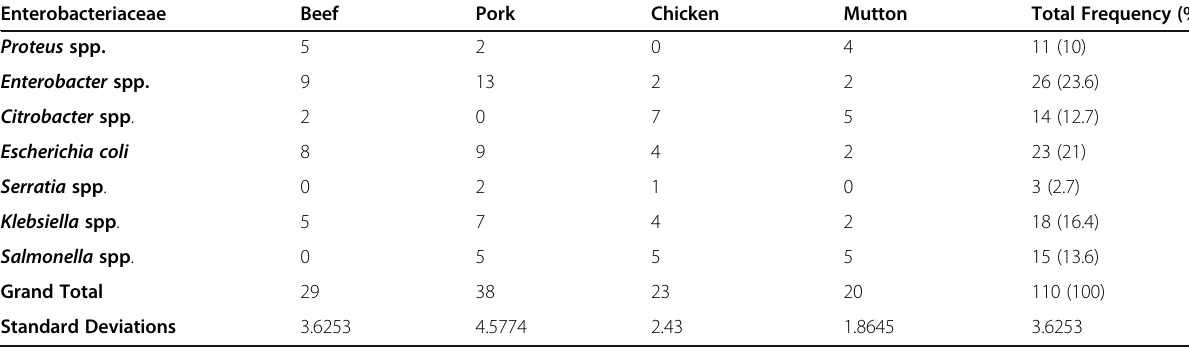
Table 1 Frequency of occurrence of members of Enterobacteriaceae in locally processed meat Enterobacteriaceae Beef Proteus spp.